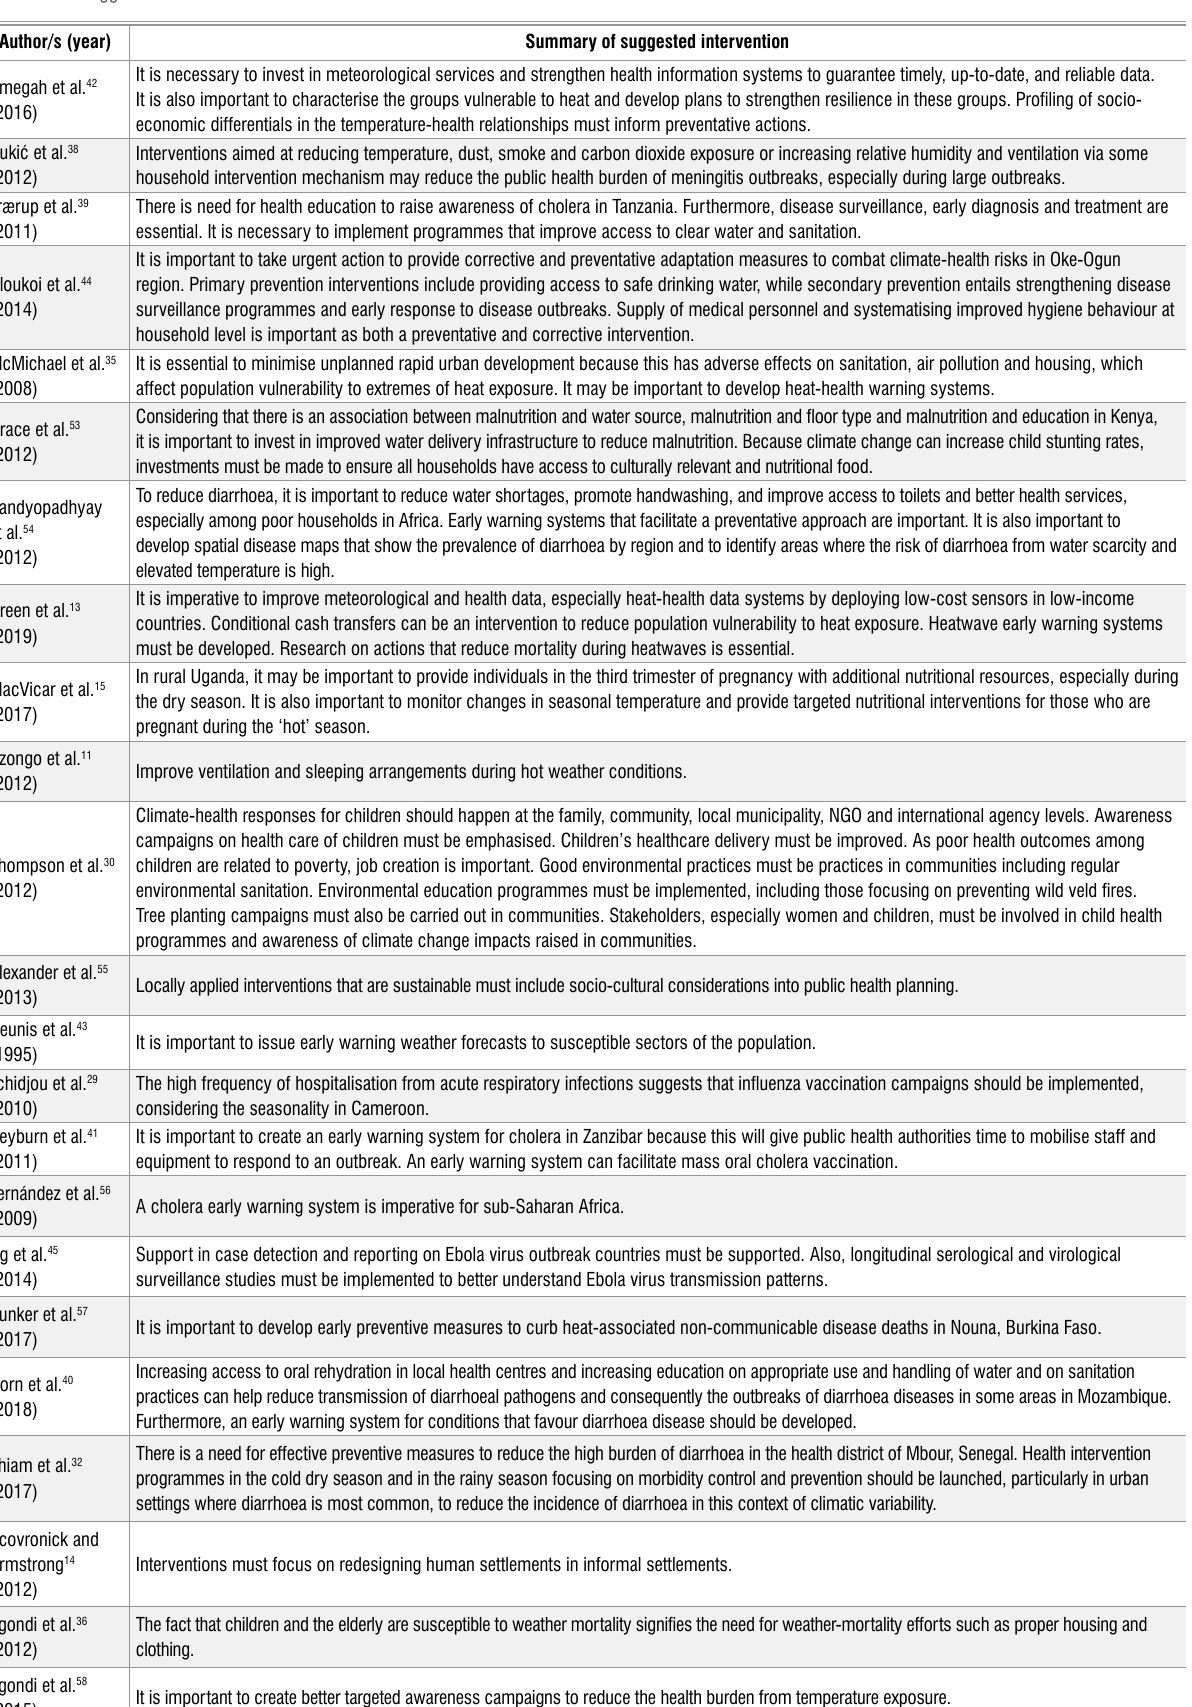
Table 2: Suggested interventions from reviewed literature